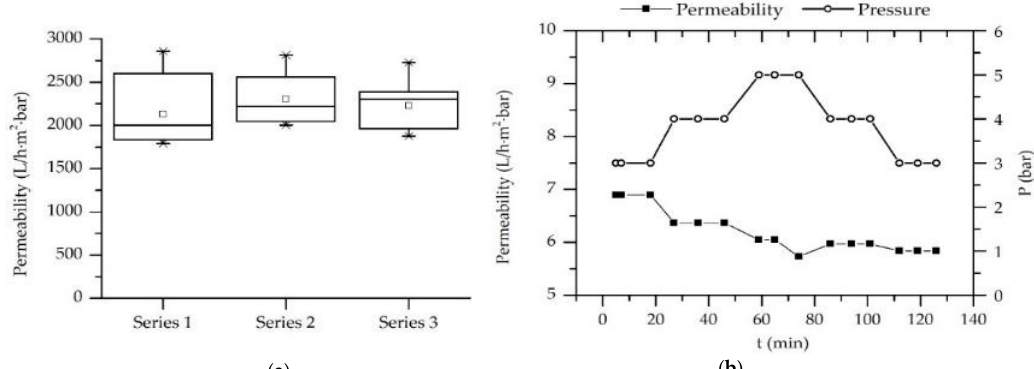
Figure 11. ( a ) Permeability of ceramic monotubes. ( b ) Permeability of a hybrid membrane as a function of pressure and filtration time.